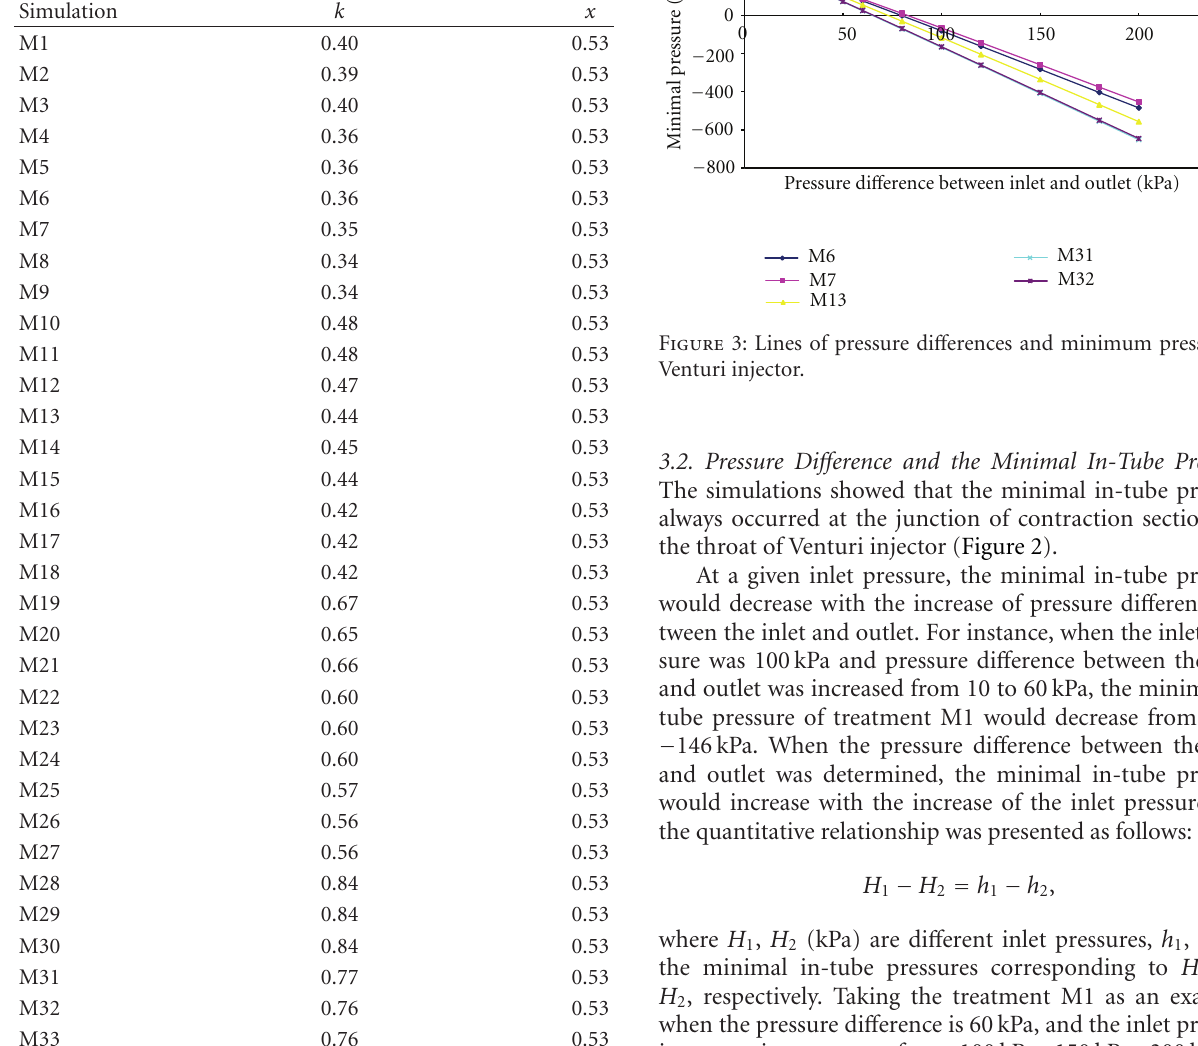
Table 3: Regression coe ffi cients of pressure di ff erences and velocity of Venturi injector.